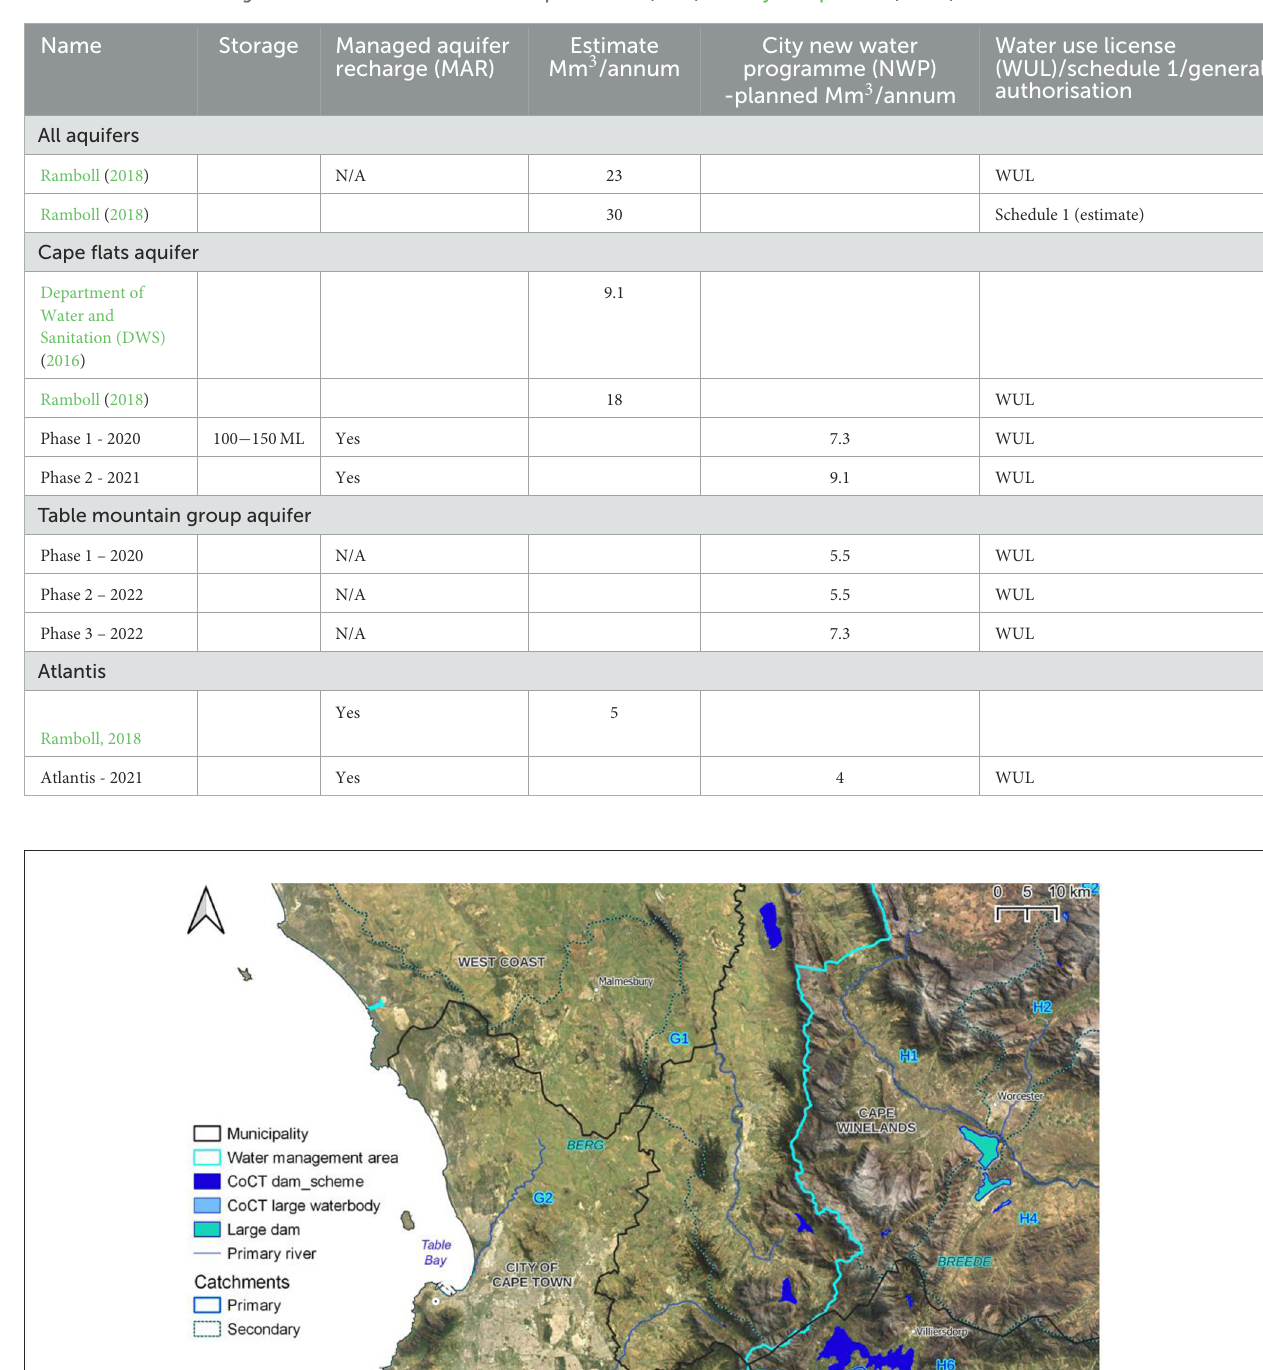
FrontiersinSustainableCities